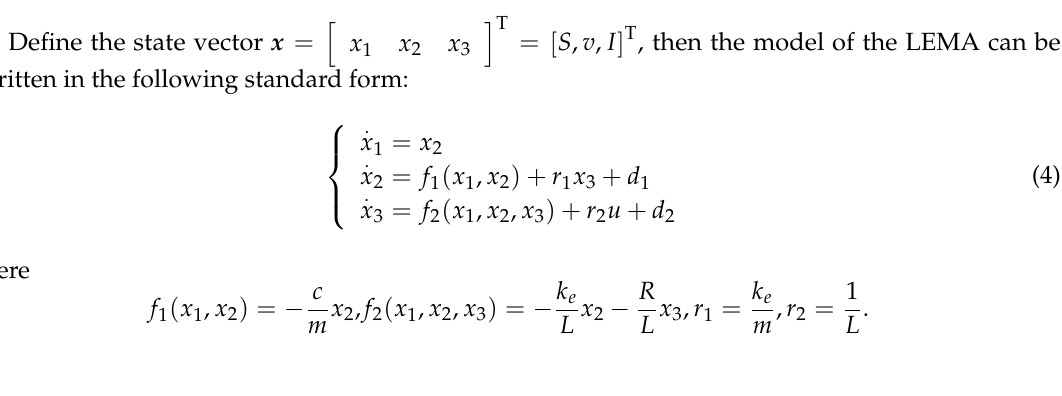
Figure 3. System block diagram of the LEMA.